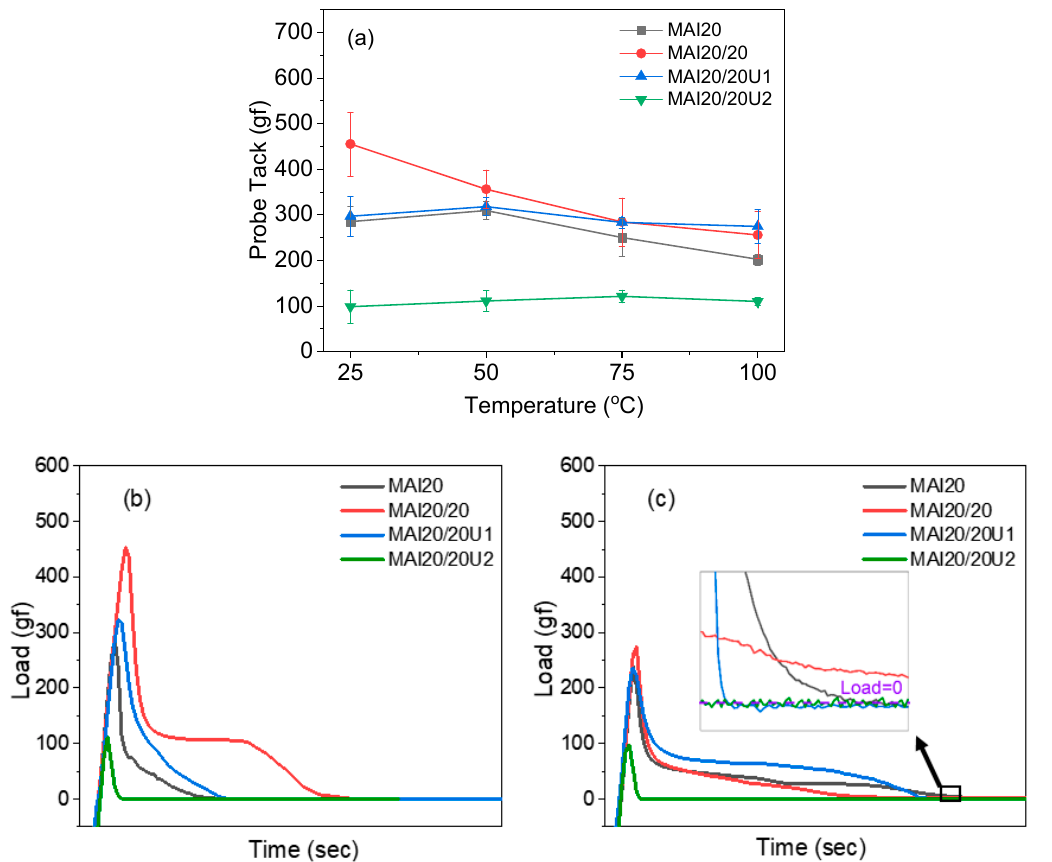
Figure 11. Probe tack of SiUDMA-modified MAI20 as a function of temperature ( a ), probe tack curves at 25 °C ( b ), and 100 °C ( c ).